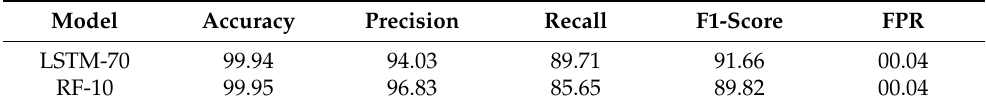
Table 3. Results for the multi-flow